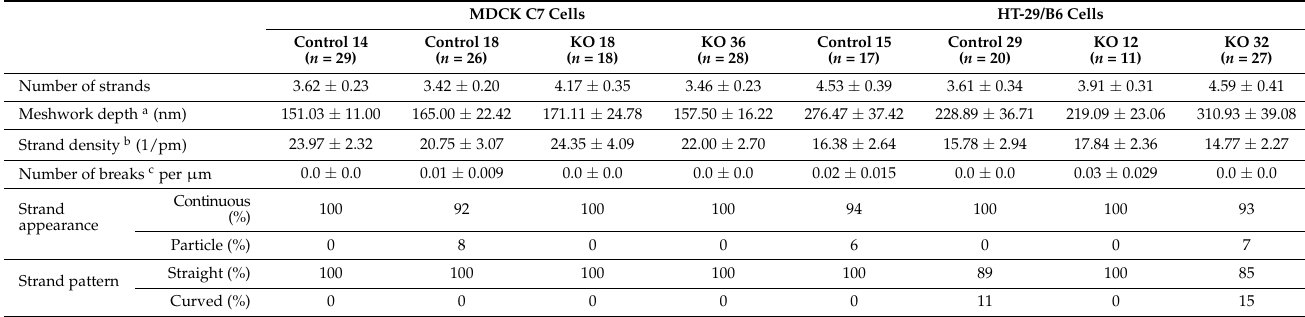
Table 1. Morphometric analysis of TJ ultrastructure of MDCK C7 and HT-29/B6 angulin-1 KO cells. No significant differences in TJ ultrastructure of control cells and angulin-1 KO cells could be detected using freeze-fracture electron microscopic analysis in MDCK C7 and HT-29/B6 cells.